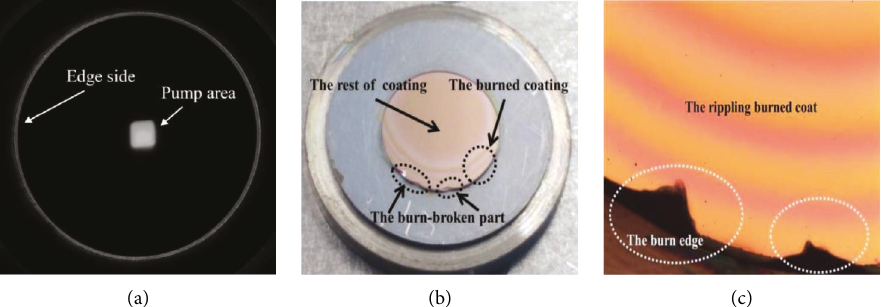
Figure 1: (a) The photograph of the pumped thin disk crystal [13]. (b) The photograph and (c) metallograph of the edge burned Yb: YAG thin disk crystal [14], which were produced by Huazhong university of science and